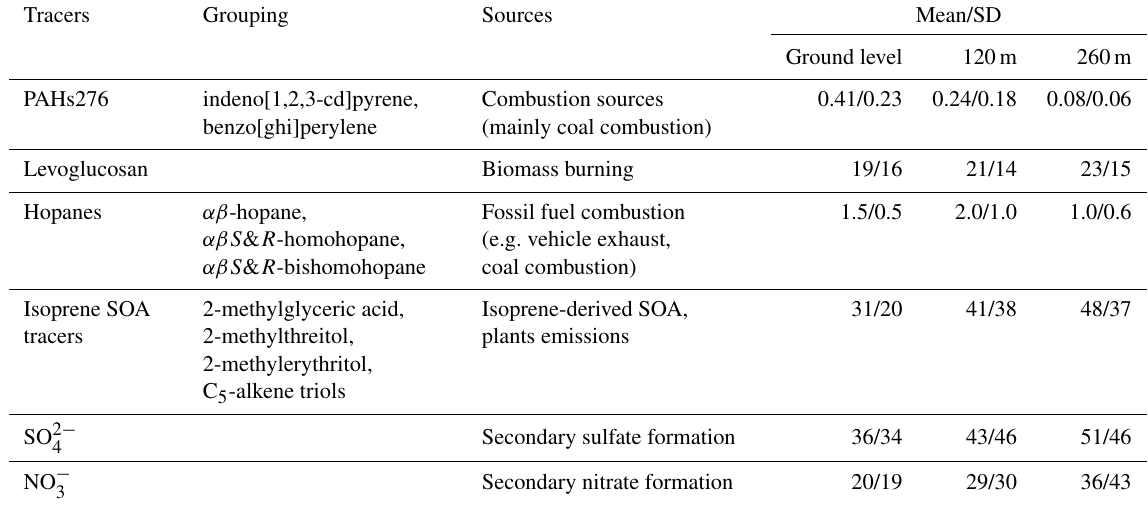
Table 3. Abundance and naming of measured ions (µgm − 3 ) and organic tracers (ngm − 3 ) used in the PMF analysis. Tracers Grouping